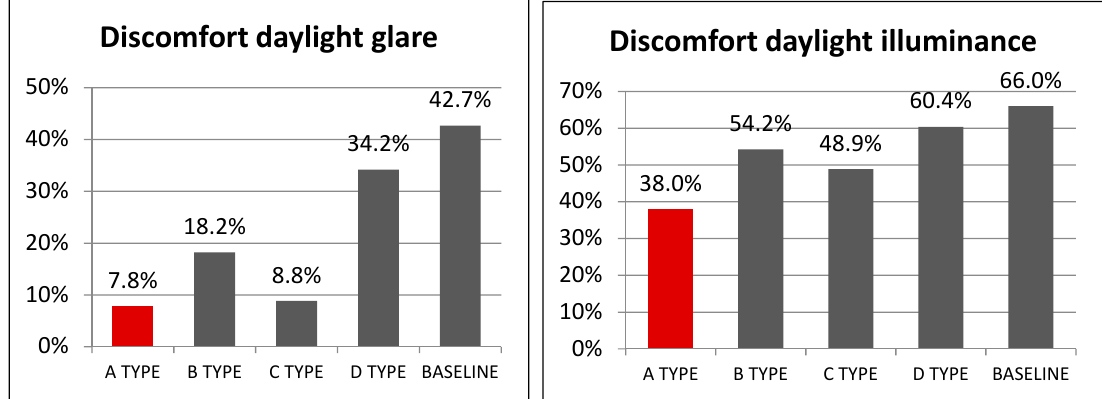
Figure 11. Annual time ratio of 22 or higher DGI (left) and annual time ratio of discomfort daylight illuminance (right).